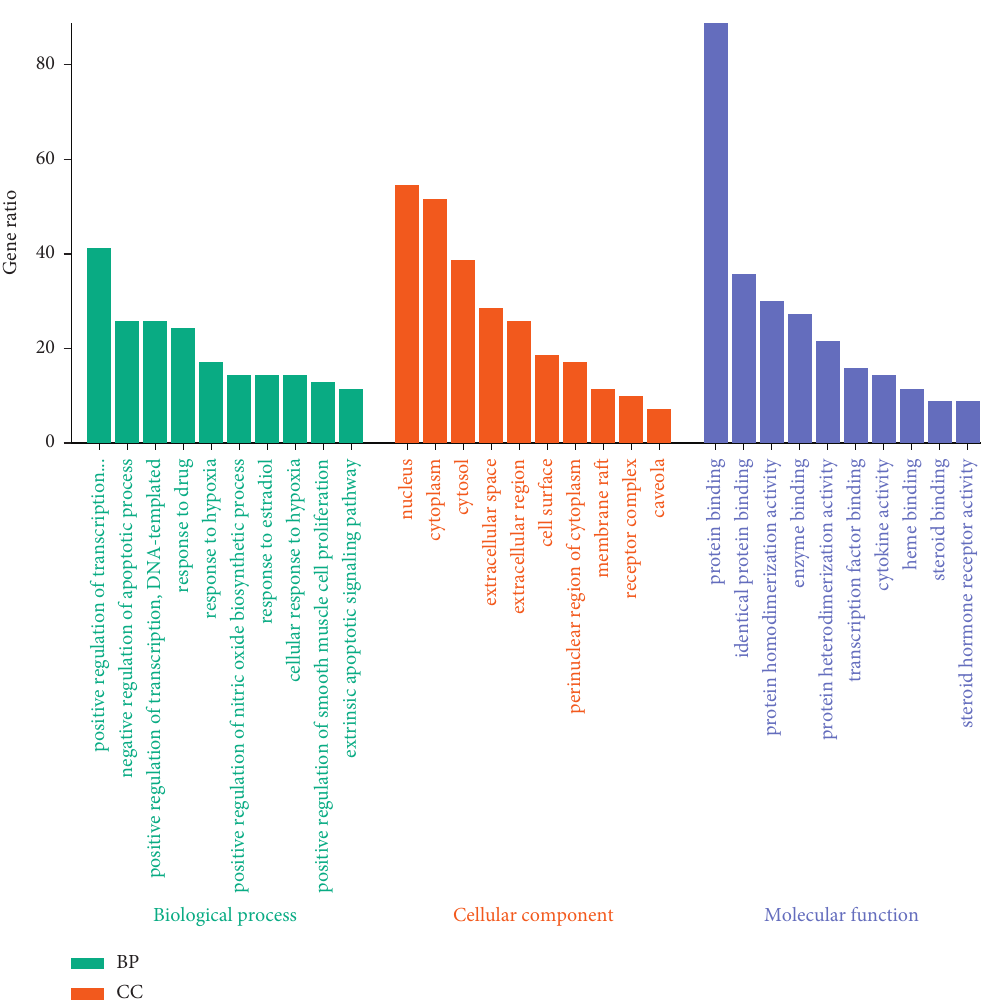
Figure 6: GO functional enrichment analysis of 149